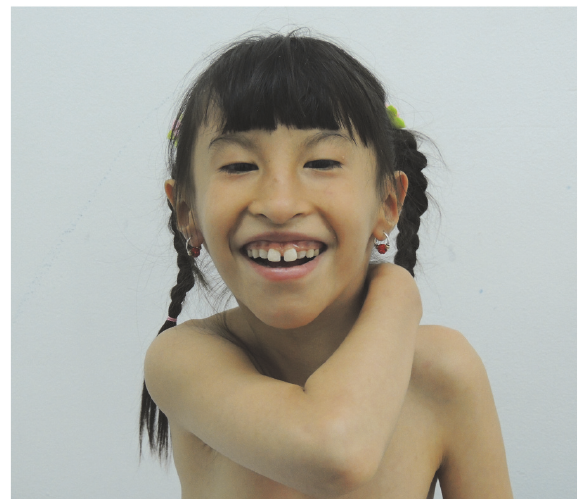
Figure 1: Microdeletion syndrome involving 8q22.2q22.3. Female patient at the age of 10 years with microcephaly, triangular face, arched eyebrows, blepharophimosis, bilateral epicanthic fold, oblique palpebral fissures, midface hypoplasia, nostrils hypoplasia, short philtrum, thin upper lip, and down-turned corners of the